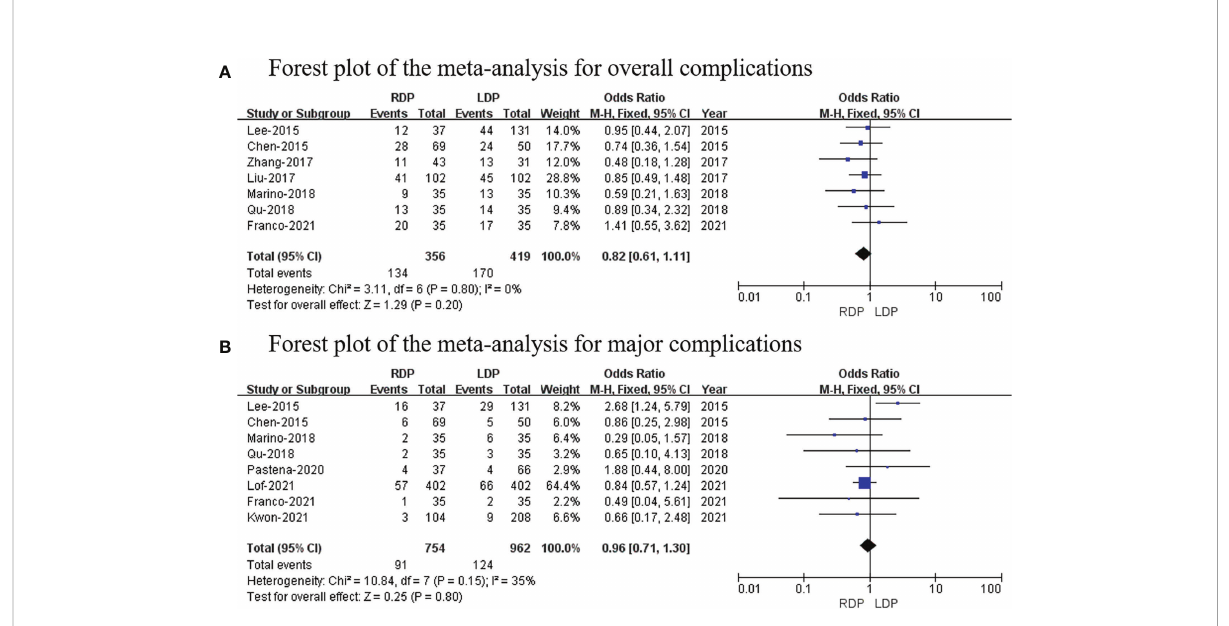
FIGURE 4 Forest plot of the meta-analysis for (A) overall complications and (B) major